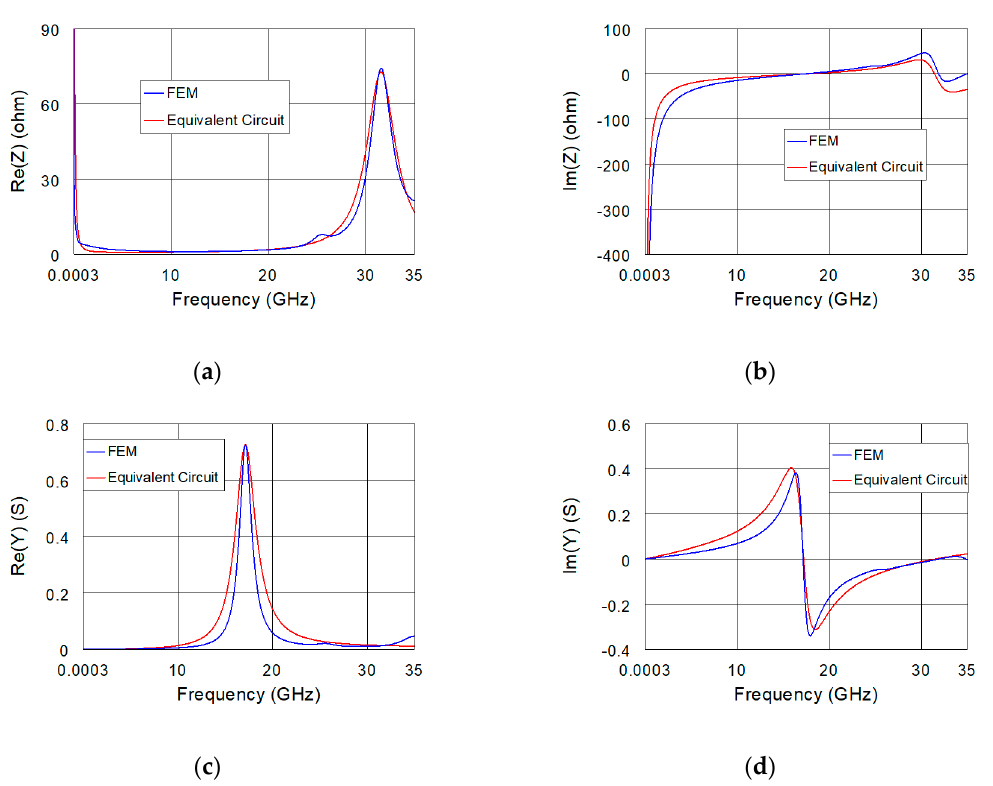
Figure 11. FEM (blue lines) and equivalent-circuit (red lines) simulations of the real and imaginary parts of the ( a , b ) impedance and ( c , d ) admittance from 0.3 MHz to 35 GHz for the IDC sensor loaded with lossless MUT having a real part of the relative permittivity of 70.